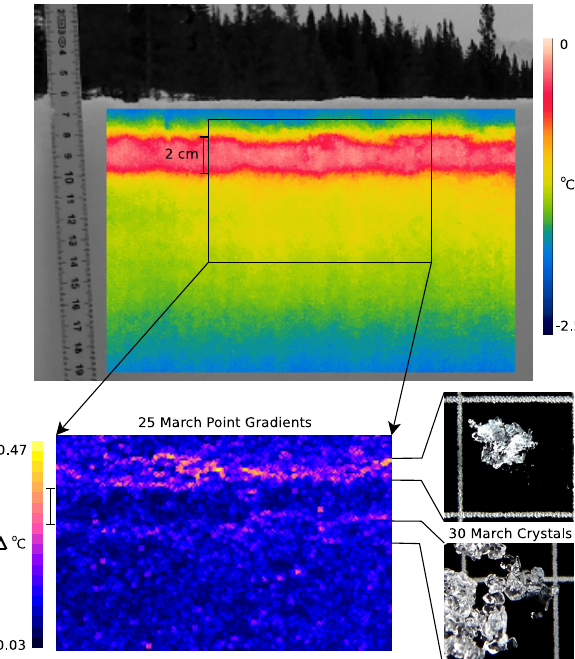
Fig. 7. Temperatures and point gradients during near-surface warm- ing. The temperatures and point gradients are from 25 March; the crystal macro photographs are from 30 March on a 3mm grid. In both upper and lower images, a span bar on the left denotes the same physical